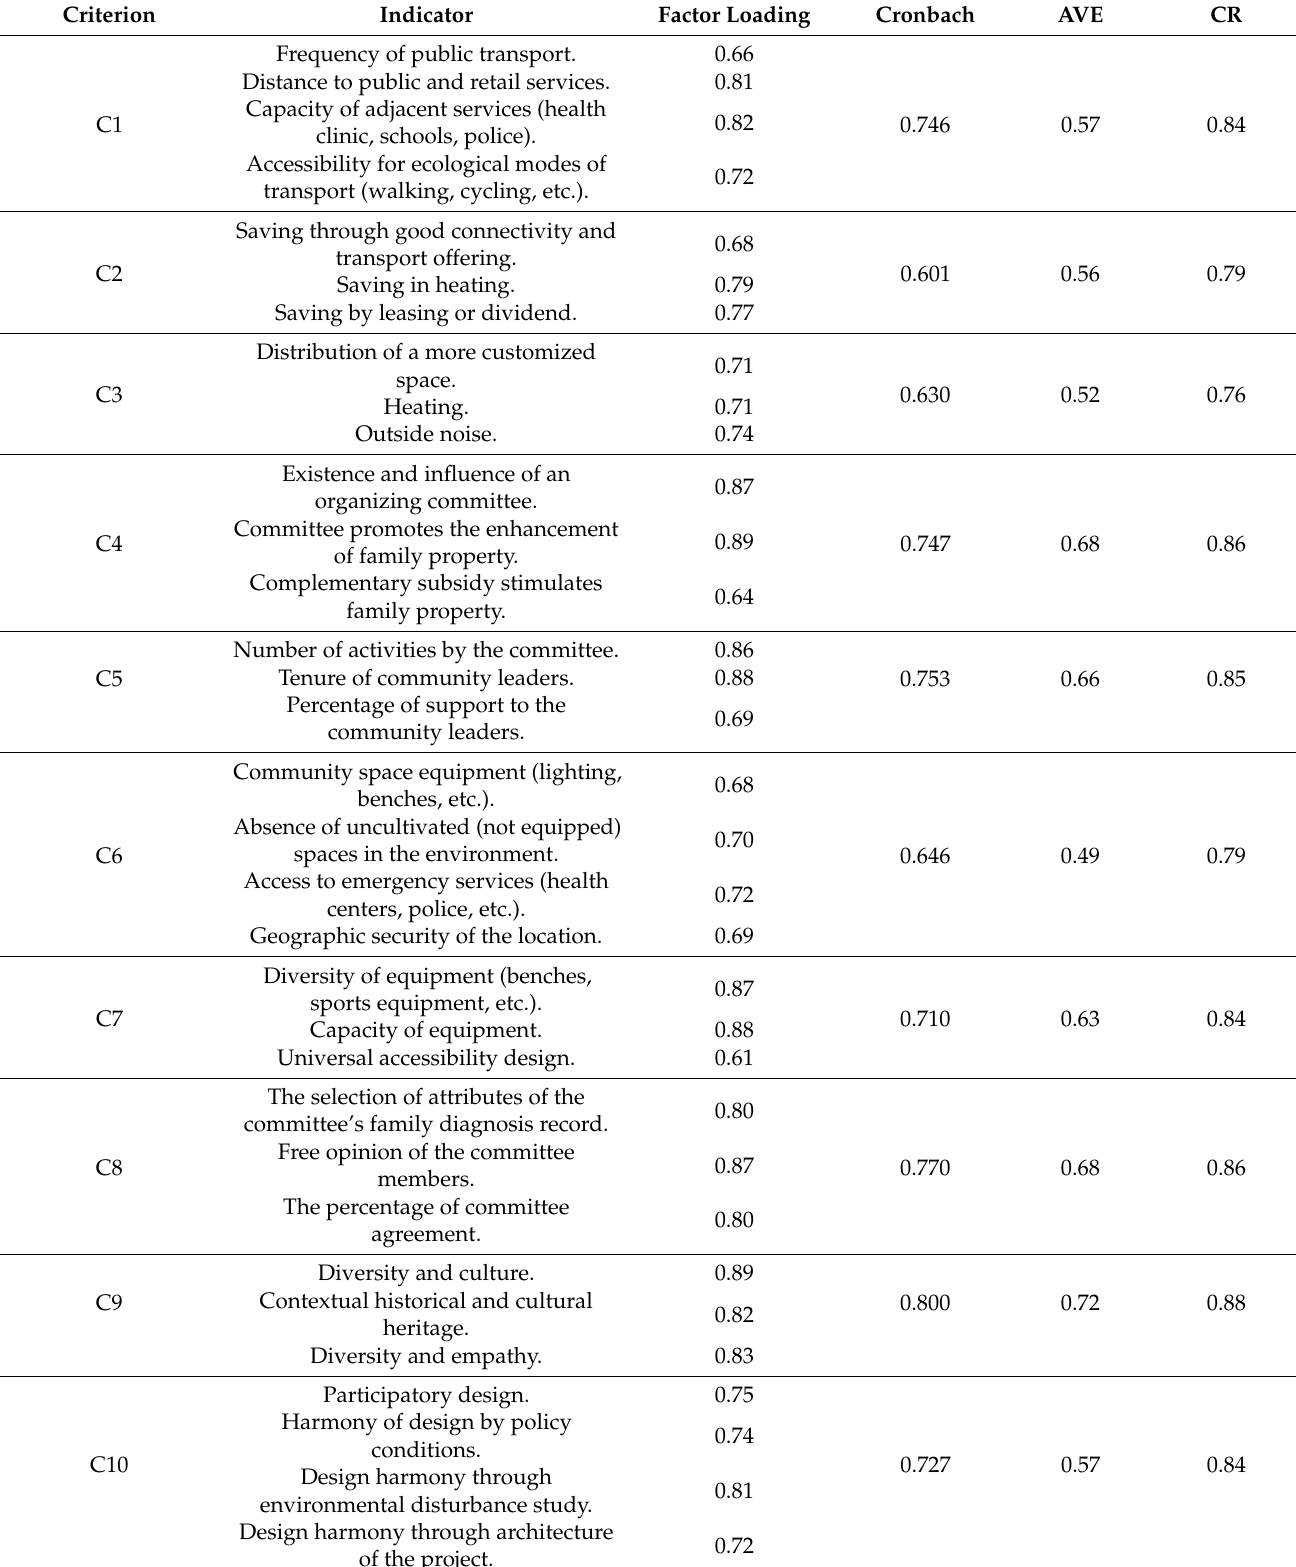
Table 3. Reliability of the indicators for the